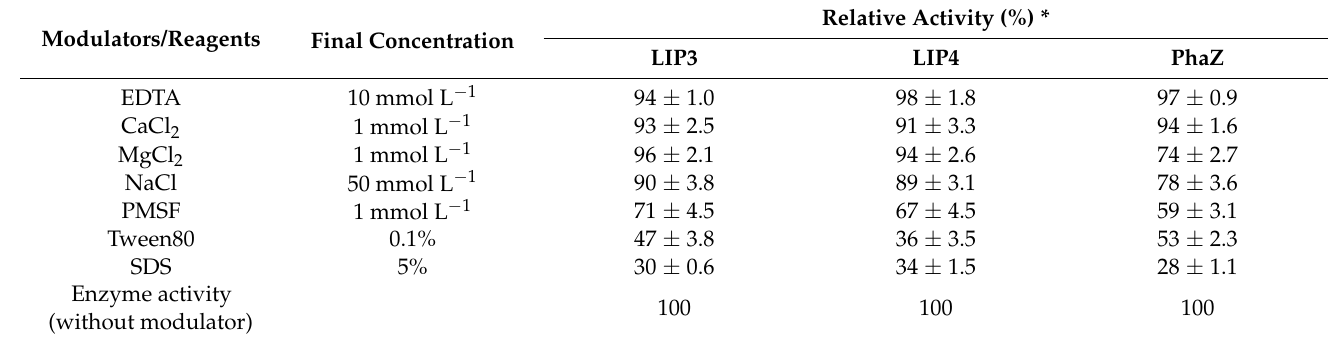
Table 2. Effects of different modulators on the activity of LIP3, LIP4, and